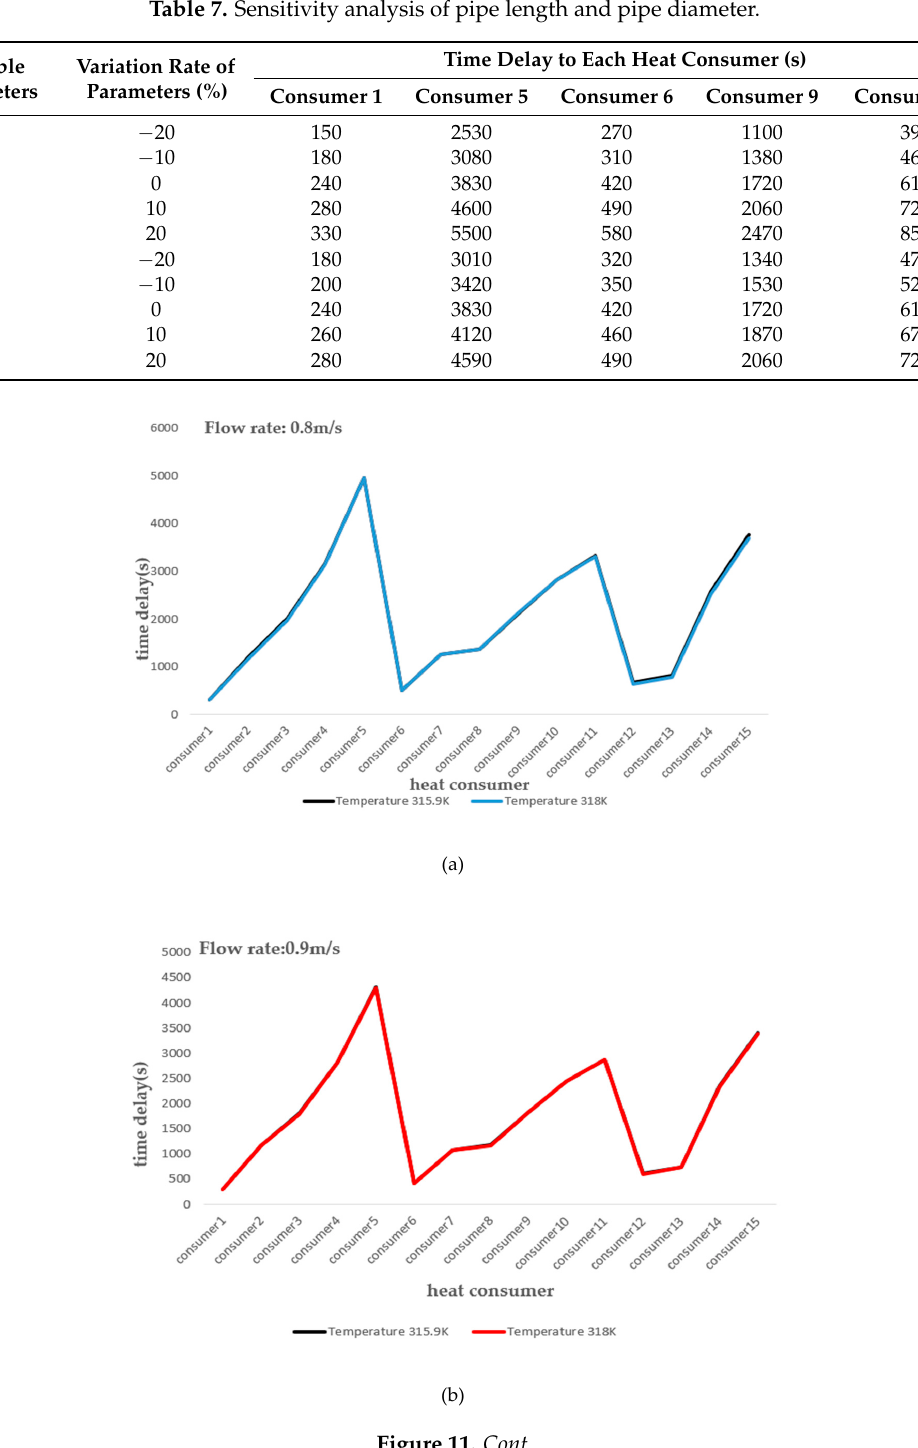
Table 7. Sensitivity analysis of pipe length and pipe